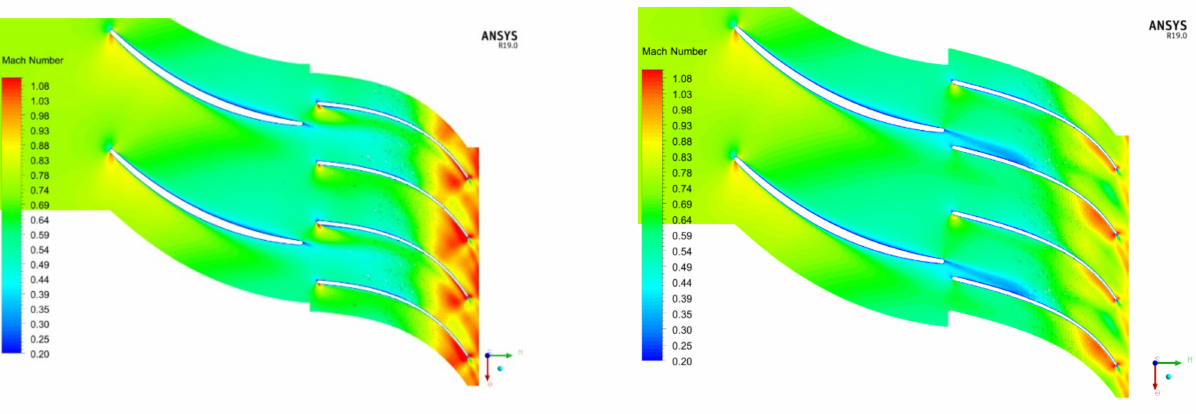
Figure 18. Relative Mach number contours at 50% span in tandem A ( left ) and Tandem B ( right ) ( m r =